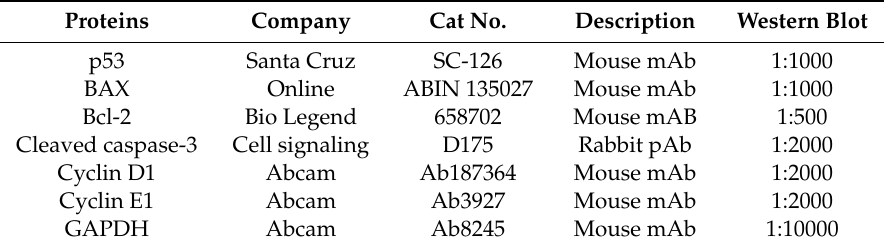
Table 1. Name and source of antibodies used in this study.